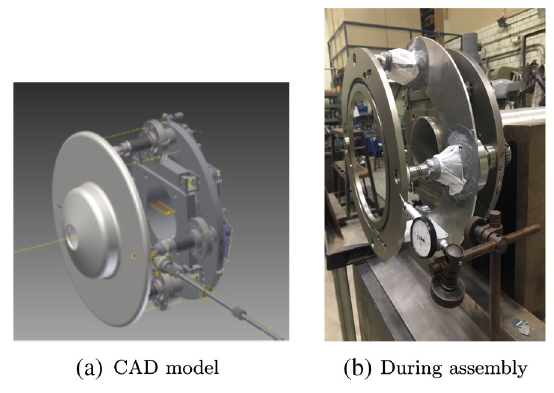
FIG. 3. CAD drawing and during fabrication pictures of the anode